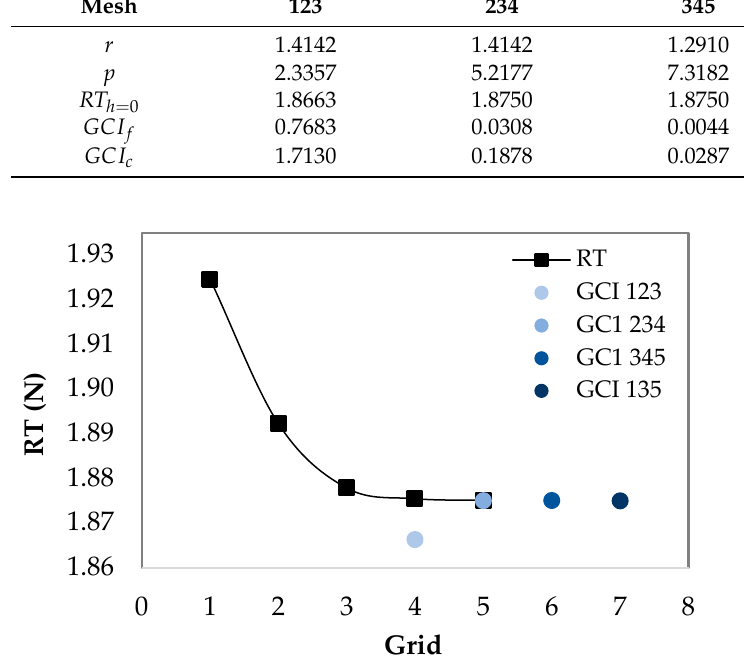
Figure 3. Grid independence index (GCI).